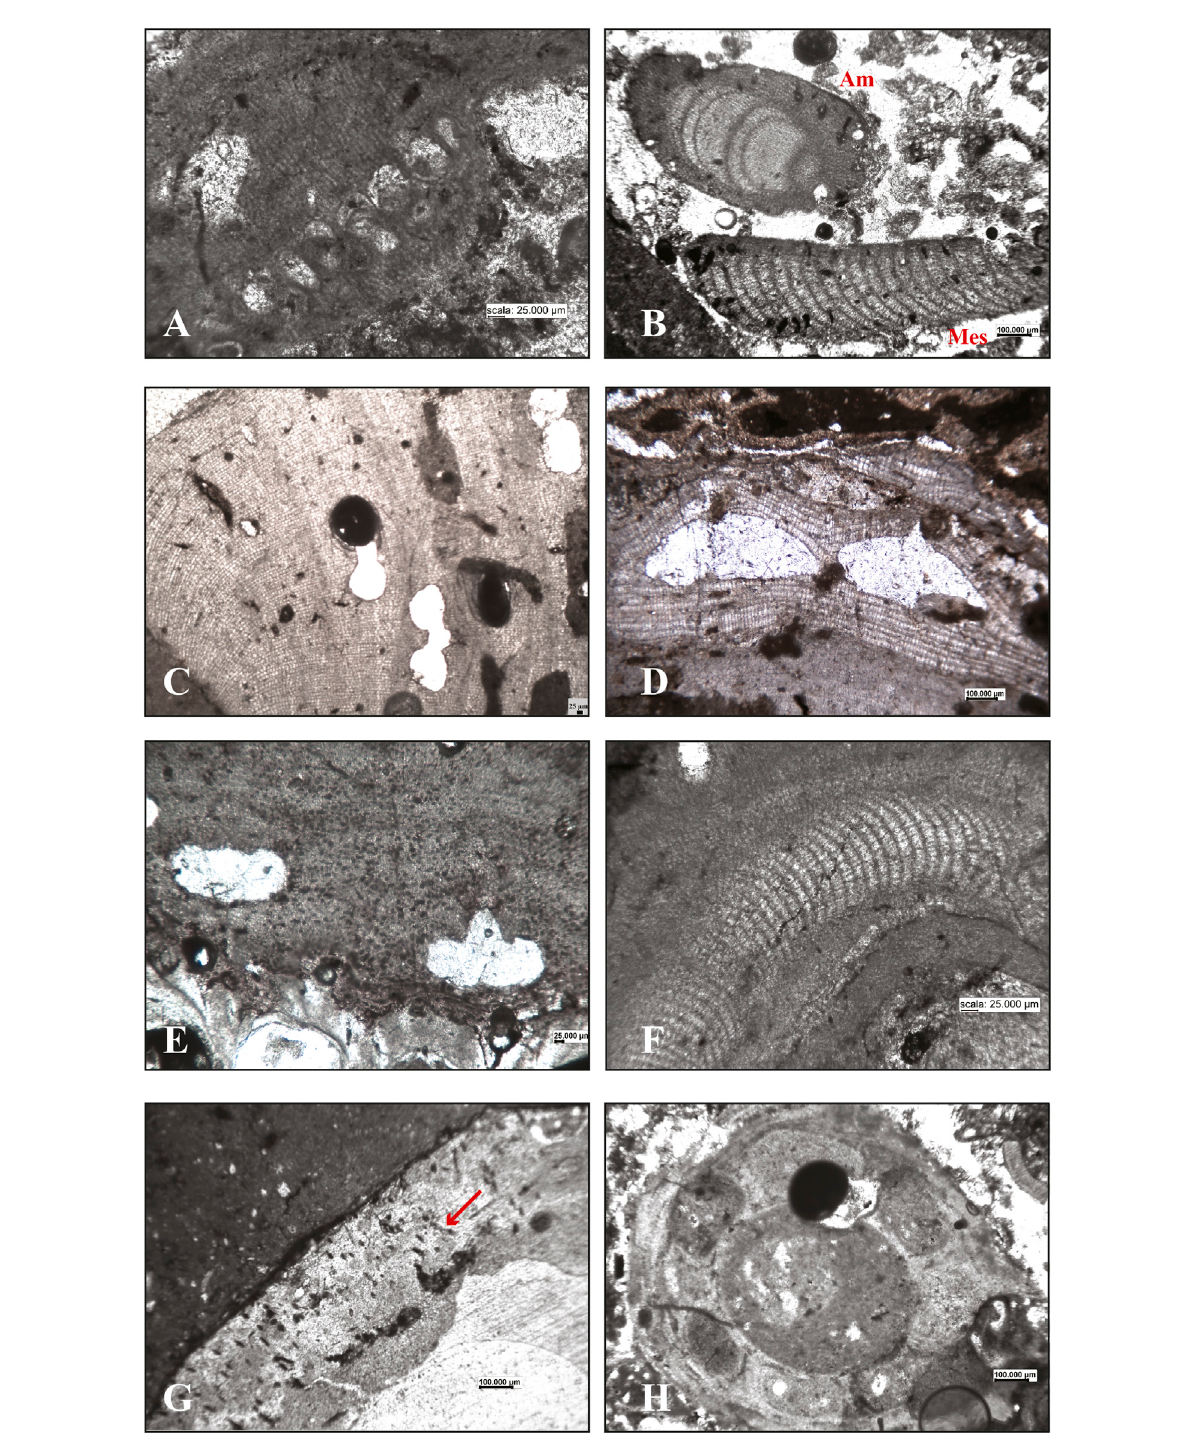
FIGURE 7 Calcareous algae in the internal structure of the studied build-ups. Corallinophycidae: (A) oblique section of solitary sporangia of Sporolithon ptychoides; (B) longitudinal section of Amphiroa intergeniculum (Am) and a fragment of a Mesophyllum sp. hypothallus (Mes); (C) longitudinal section of Lithophyllum gr. stictiforme ; (D) longitudinal section of Titanoderma pustulatum showing the distinctive palisade cells and two uniporate conceptacles; (E) Spongites fruticulosus growing on a bryozoan colony; (F) the hypothallus of a Mesophyllum sp. Peyssonneliales: (G) Peyssonnelia sp, hypobasal aragonite calci fi cation showing traces of rhizoids (arrow). Charophyta: (H) unidenti fi ed charophyte